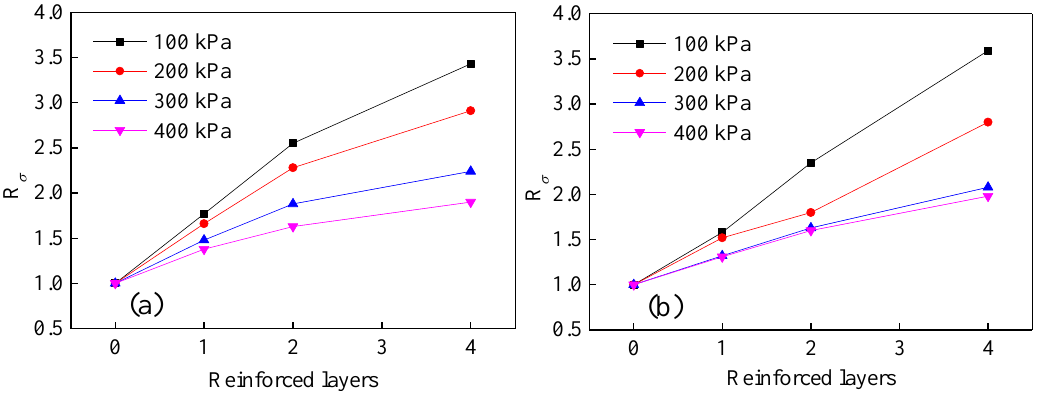
R under different reinforced 